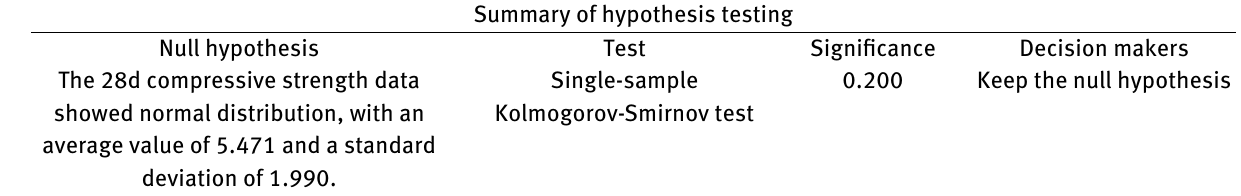
Summary of hypothesis testing